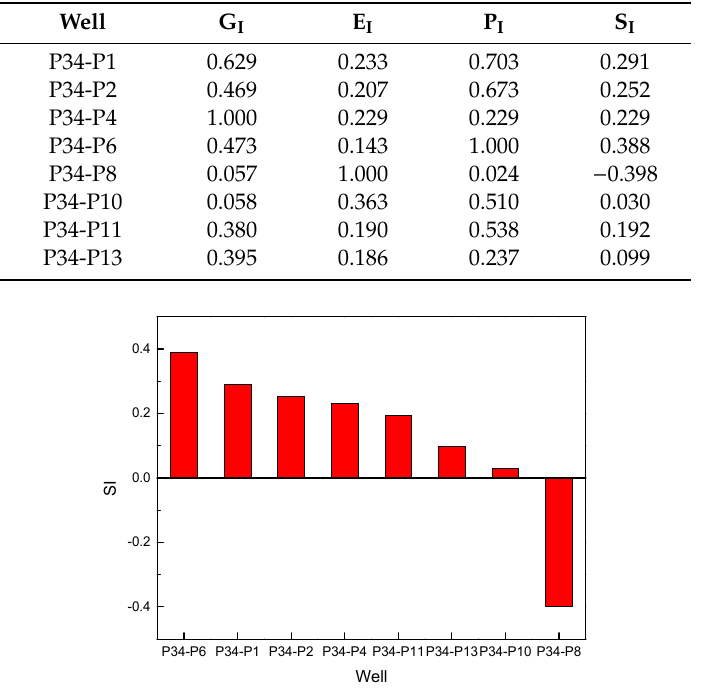
Table 1. Calculation result of decision index of horizontal well selection in the target test area.